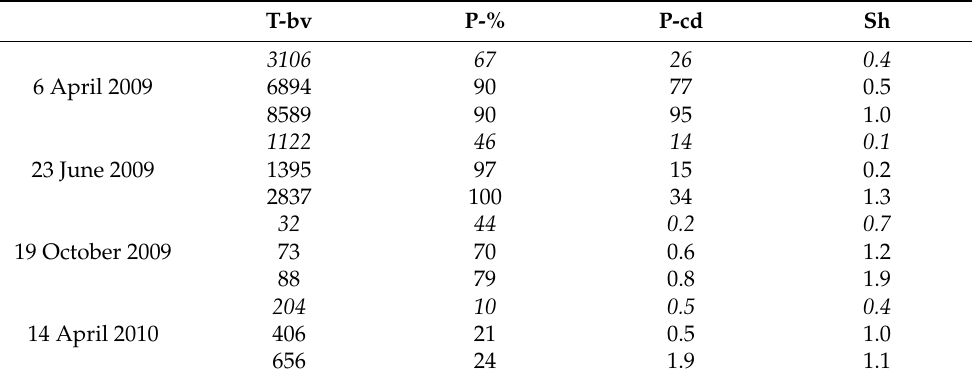
Table 2. Statistics of the main phytoplankton descriptors related to station St6 in the four field campaigns, reporting minimum (italic), median (bold), and maximum (normal) values. T-bv = total biovolume (mm 3 m − 3 ); P-% = percentage of P. rubescens to the total biovolume (%); P-cd = P. rubescens cell density (10 6 cell L − 1 ); SI = Shannon index. 6 April 2009: N = 6, Dr = 0.5–15; 23 June 2009: N = 5, Dr = 0.5–20; 19 October 2009: N = 4, Dr = 0.5–20; 14 April 2010: N = 3, Dr = 0.5–20. N = number of samples; Dr = depth range